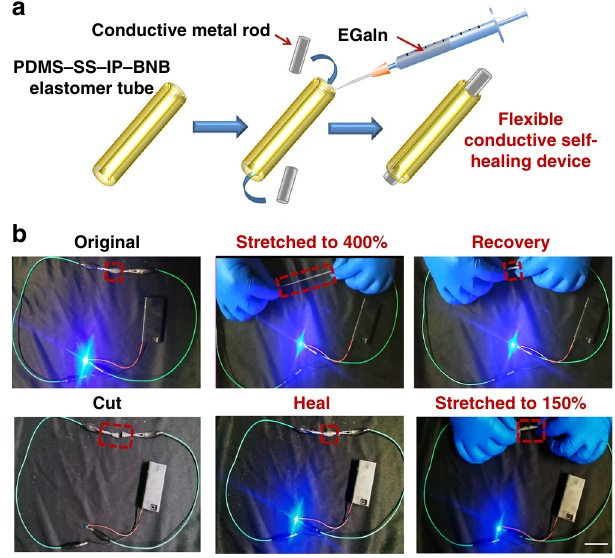
Fig. 4 A self-healable and stretchable arti fi cial conducting device based on PDMS – SS – IP – BNB elastomer. a Components and structure of the electrical conductor using an elastomer tube. EGaIn is covered with the elastomer that serves as insulator. b The self-healable and stretchable conductor applied with an LED in series. The electrical conductor can be stretched to 400% its original length and recover its original size; moreover, the electrical conductivity of a broken conductor can be recovered after 10 min healing, and the healed conductor can still be stretched to 150% its original size (scale bar = 4.0